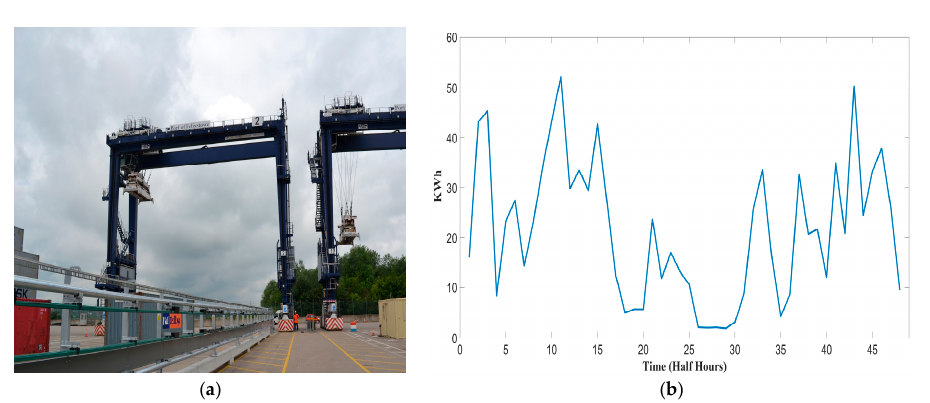
Figure 1. Crane system: ( a ) electrified RTG crane at the Port of Felixstowe; ( b ) an example of the actual electrified RTG crane demand for a specific day.